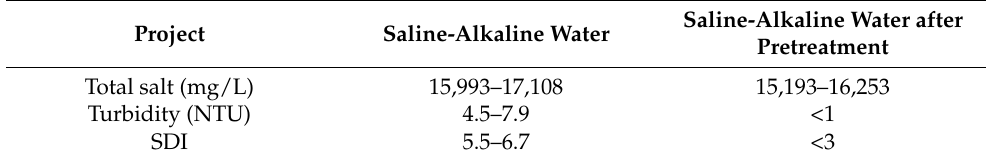
Table 1. Quality of saline-alkaline water before and after